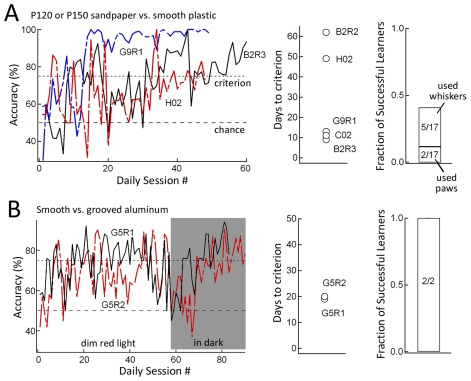
Learning curves for sandpaper and smooth vs. grooved discrimination.
A, Sandpaper discrimination. Left, learning curve for 3 example rats. Day is is start of stimulus-reward contingency (Stage 3). Middle, Number of daily training sessions to reach criterion performance, for each successful learner. Right, Fraction of successful learners. B, Smooth-grooved discrimination. Left, learning curve for 2 rats. Rats were initially trained in dim light, and then switched to darkness. Middle, number of training sessions to reach criterion performance. Right, Fraction of successful learners.